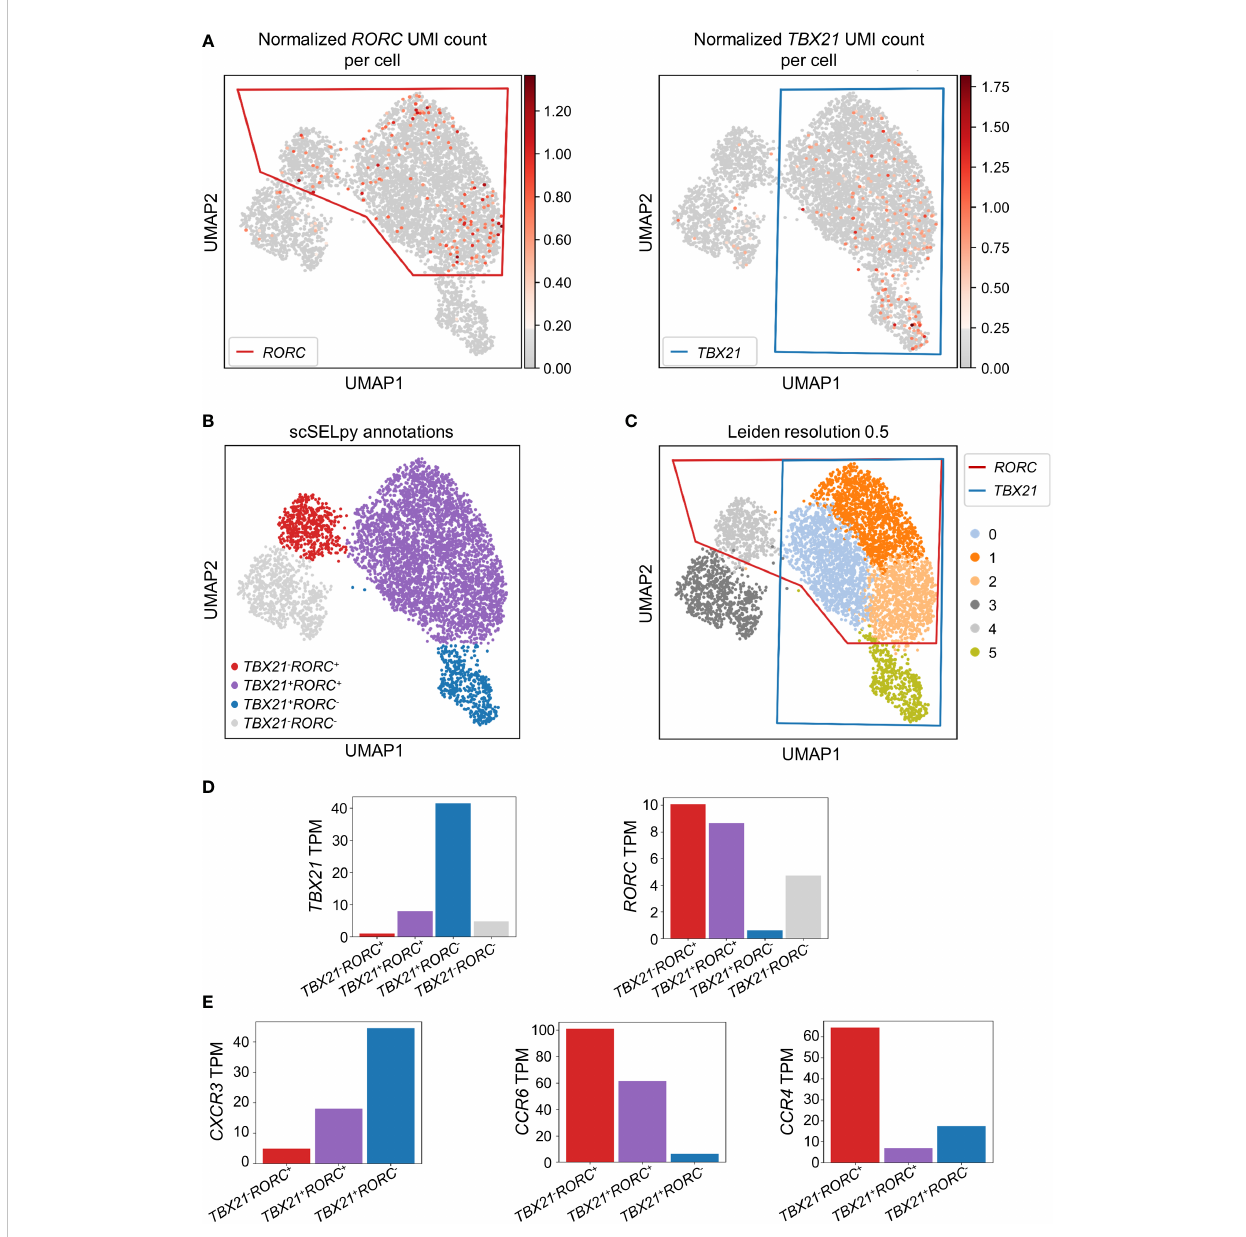
FIGURE 3 Identi fi cation and analysis of effector memory T cell subsets with scSELpy. (A) Selection of regions enriched in cells expressing the T cell transcription factors TBX21 or RORC among effector memory T cells in the cells obtained in Figure 2C. (B) UMAP plot with cells annotated by scSELpy based on the selections made in (A). (C) Clustering of the cells based on the leiden algorithm with a resolution of 0.5. (D) Barplot showing the TBX21 and RORC transcripts per million transcripts (TPM) for the populations identi fi ed in (B) . (E) CXCR3 , CCR6 and CCR4 TPM in the indicated